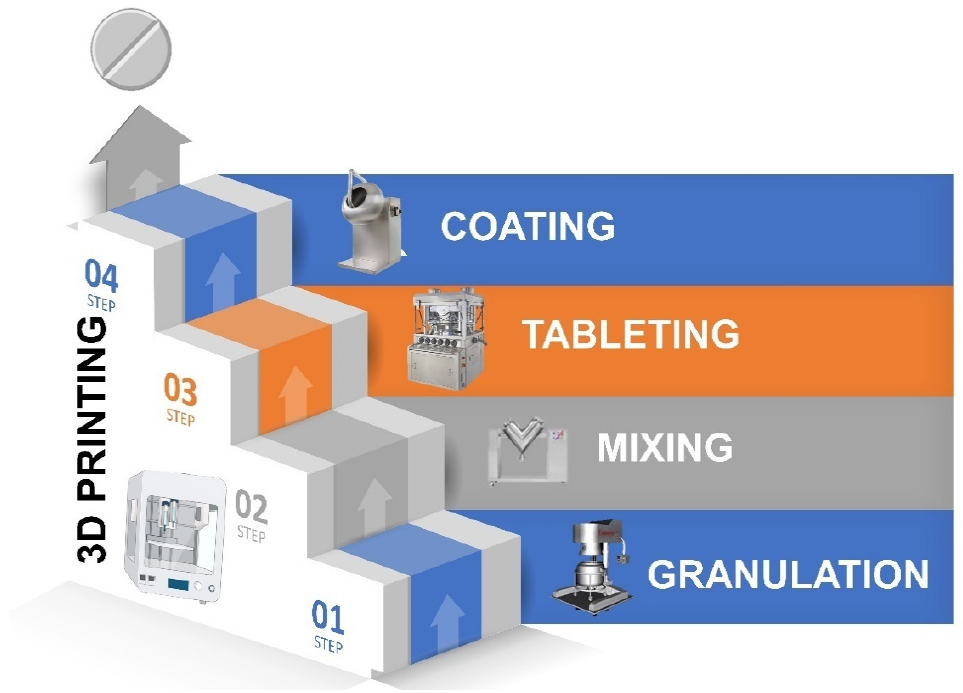
Figure 3. Comparison of conventional solid dosage form manufacturing vs. 3D printing.